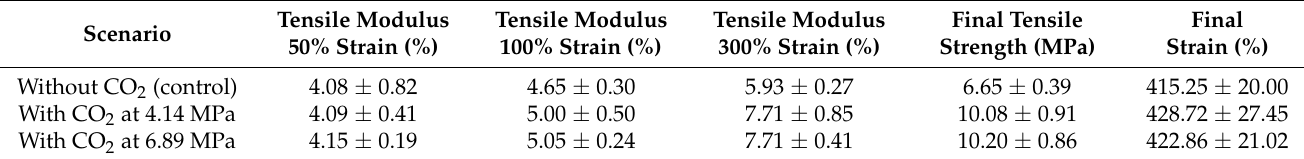
Figure 6. Stress–strain relationship of Pellethane TPU with and without CO 2 . Table 6. Mechanical properties of Pellethane TPU with and without CO 2 .